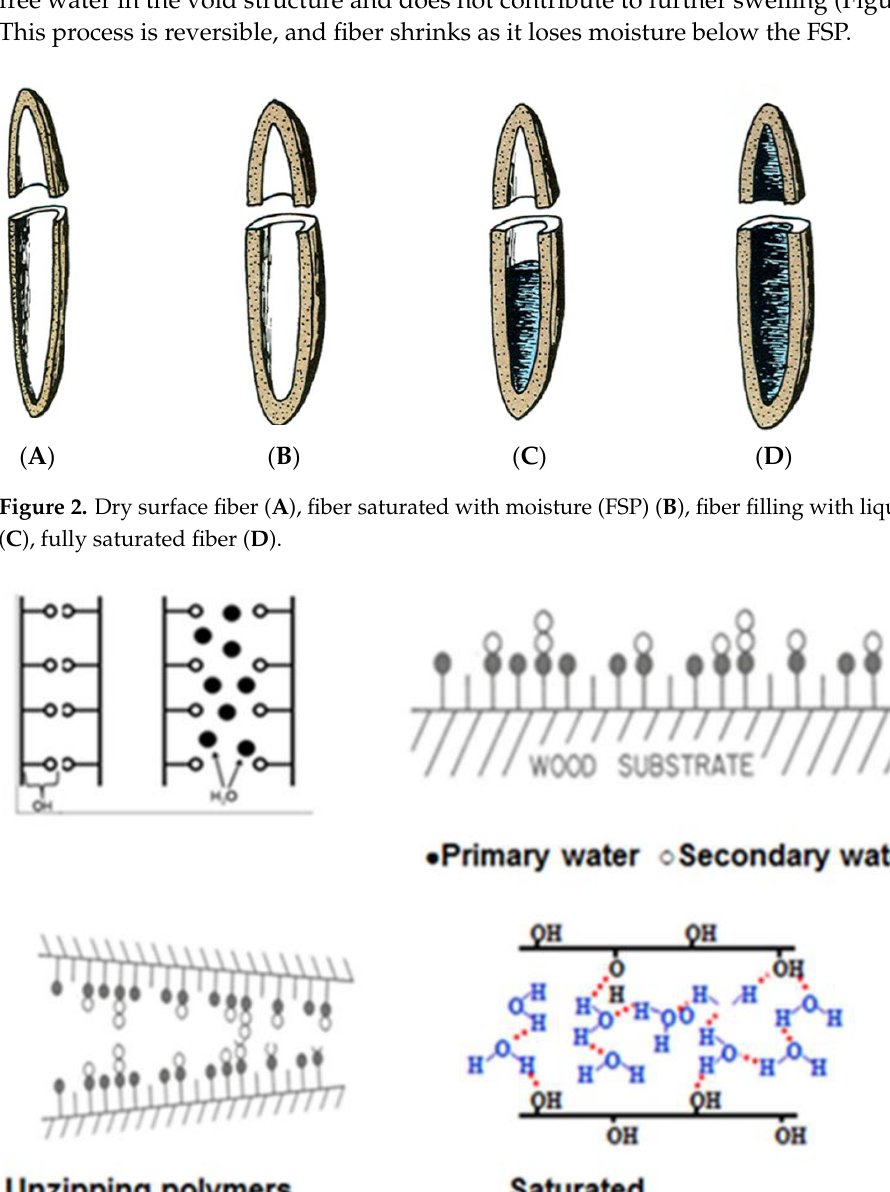
Figure 3. Moisture absorption and adsorption in a wood surface.